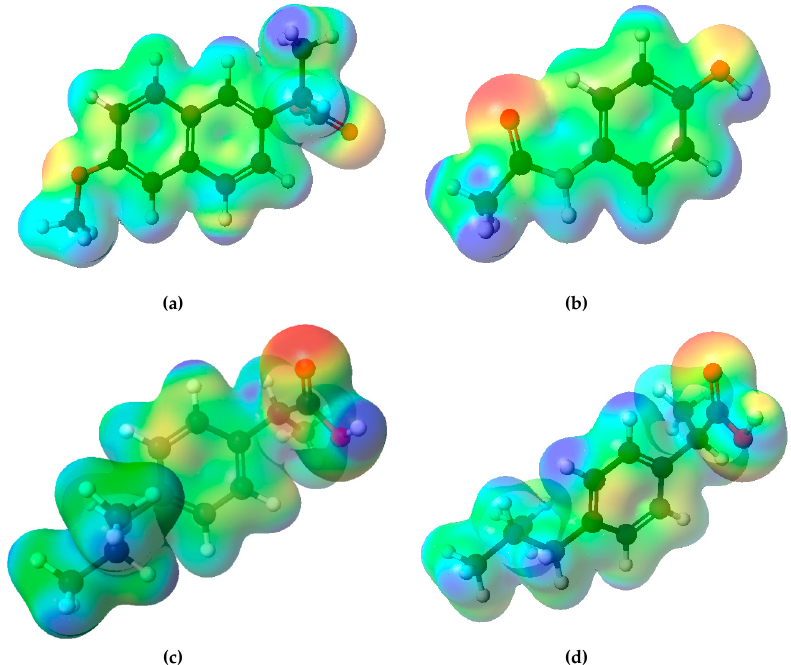
Figure 2. Electrostatic potential energy maps for ( a ) ( S )-naproxen, ( b ) paracetamol, ( c ) ( S )-ibuprofen, ( d ) ( R )-ibuprofen. Blue surface indicates positive value of electrostatic potential (localized positive charge) and the red one–negative value (localized negative charge). Electron density at the surface is 0.01 e/A 3 .